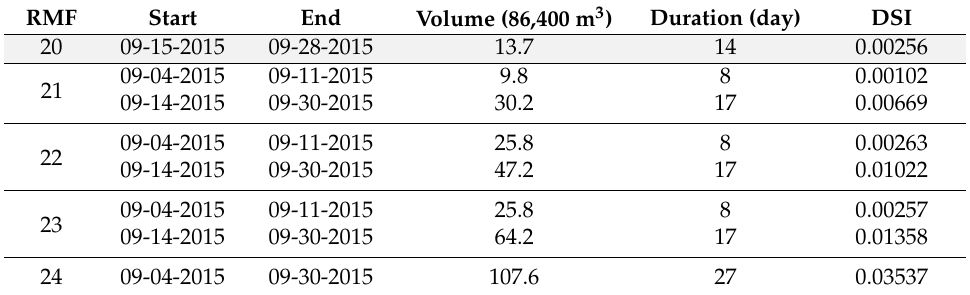
Table 6. Streamflow deficit events and their severity indexes for Gongju (2012–2016, irrigation period).